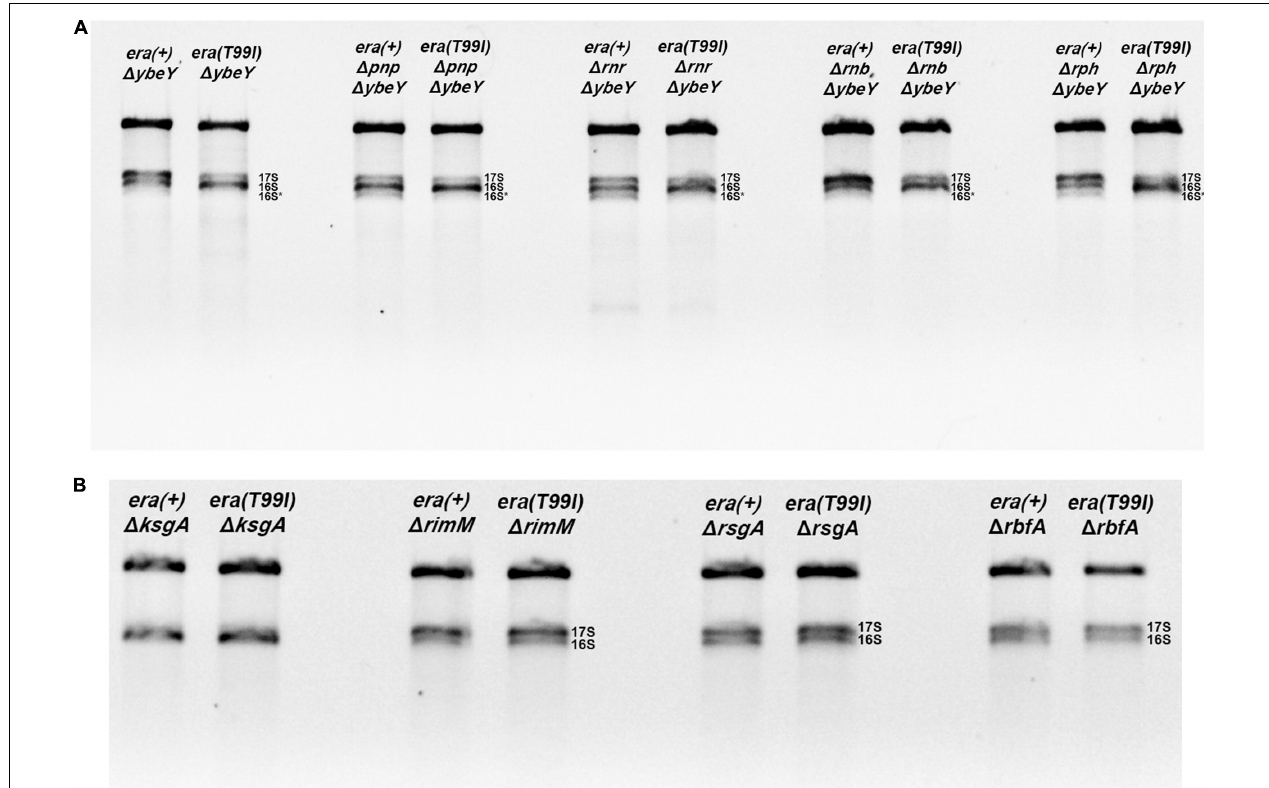
FIGURE 5 | Total RNA extracted from the indicated strains were separated using Synergel-agarose gel electrophoresis. Representative gel images of at least three independent determinations is shown. (A) The (cid:49) ybeY strains lacking one of the indicated exonucleases [PNPase ( pnp ), RNase R ( rnr ), RNase B ( rnb ), RNase PH ( rph )] did not affect the era(T99I)- mediation suppression. The double mutants showed decrease in 17S rRNA and/or increase in 16S rRNA in the presence of era(T99I) . (B) The era(T99I) dependent improvement of 16S rRNA processing was not observed in the strains lacking one of the maturation factors (KsgA, RimM, RsgA, or